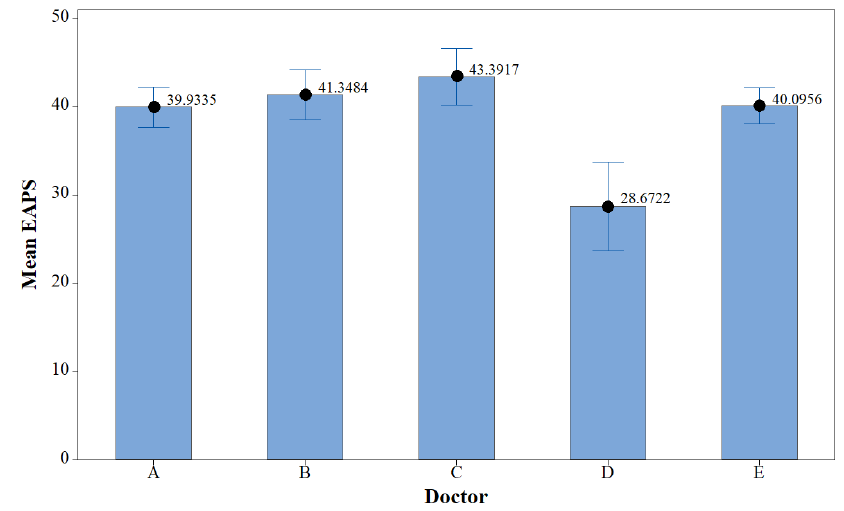
Figure 15. Interval plot of EAPS data distribution.